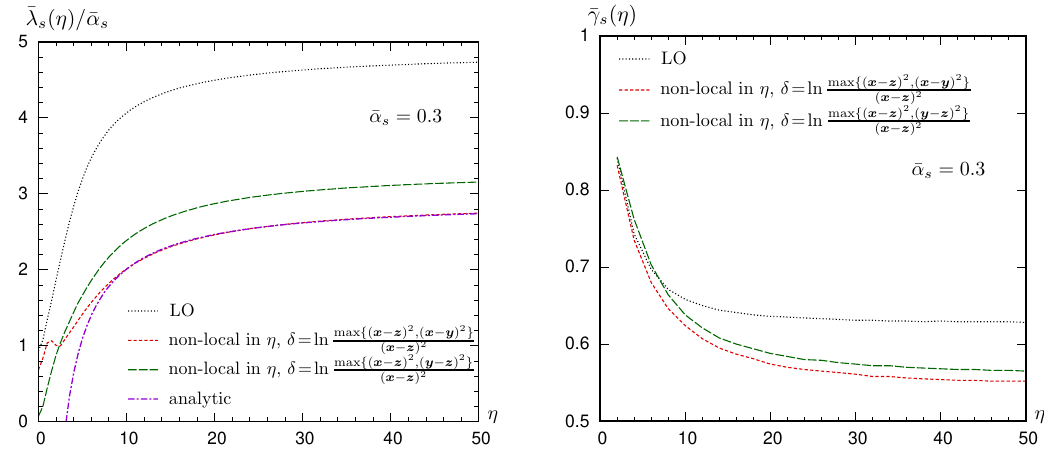
Figure 7 . Left: the front speed (divided by (cid:22) (cid:11) s ) as a function of (cid:17) , obtained from the numerical solution to eq. (6.1) for two di(cid:11)erent (cid:14) -shifts: cf. eqs. (5.6){(5.7) (red short-dashed curve) and eq. (5.8) (green long-dashed curve). The analytic asymptotic expansion for the \canonical" shift and the LO result are also shown. Right: the slope as a function of (cid:17) , obtained from the same equation and with the same two prescriptions for the rapidity